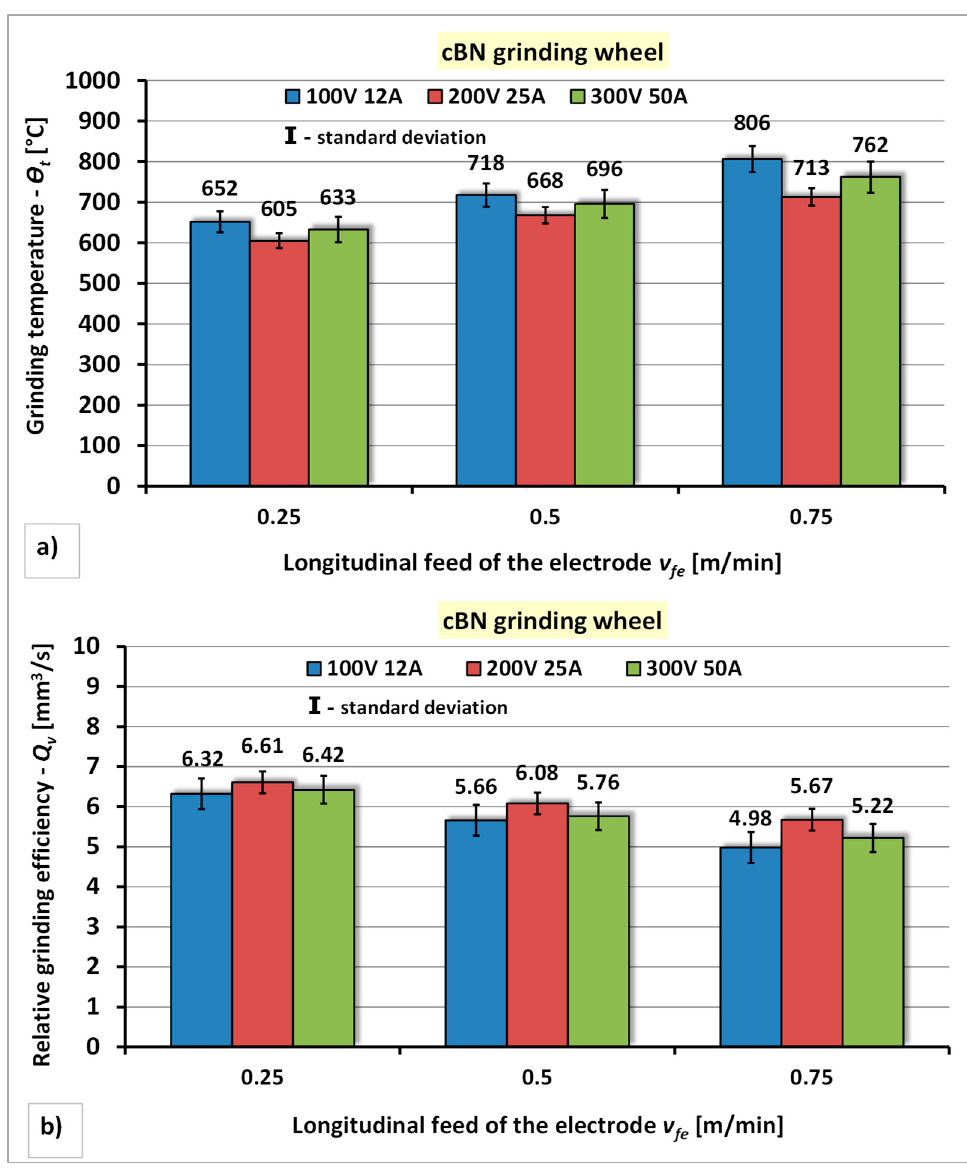
Figure 12. The effect of the generator power and longitudinal feed of the electrode during electrodischarge dressing of a cBN grinding wheel using a segmental electrode: ( a ) On the grinding temperature— Θ t ; ( b ) On the relative grinding efficiency— Q v .